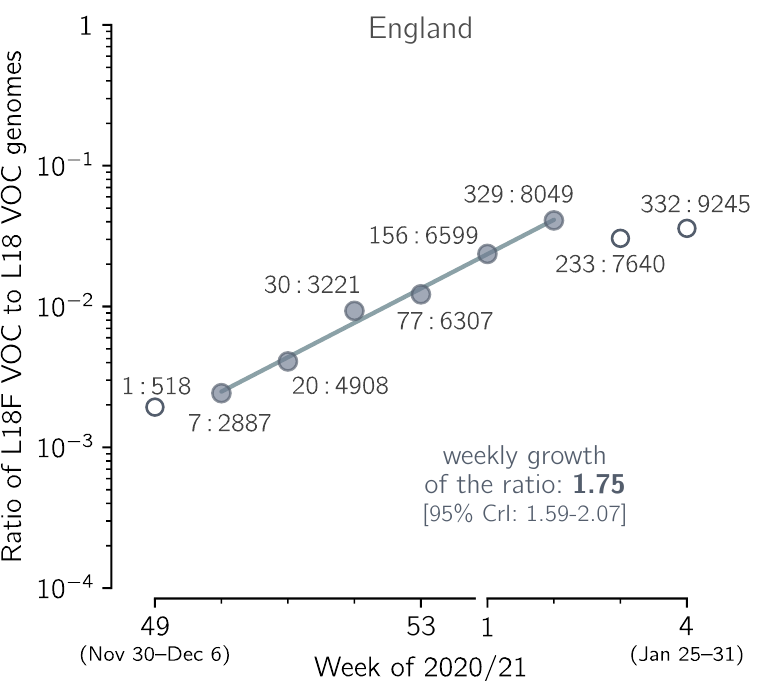
Figure 7. The growth of the spike L18F substrain in relation to the L18 VOC strains. The ratio v L of the number of VOC genomes conferring spike L18F mutation to the number of non-mutated (L18) VOC genomes collected in the period between week 49 of 2020 and week 3 of 2021 in England. Data aggregated into weeks indicated that v L changes from 7:2887 = 0.0024 in week 50 of 2020 to 329:8049 = 0.041 in the second week of 2021, i.e., 16.9 times, meaning that v L increases 16.9 1/5 = 1.76-fold per week. The trend line is fitted to data points shown as filled circles. The weekly growth rate of the ratio is 1.75. The 95% CI calculated as 1.96 × standard error of the slope is [1.66–1.85]; the 95% CrI calculated assuming binomial distribution of substrain genomes is [1.59–2.07]. Data points in week 50 of 2020 and week 2 of 2021 are labeled with ratios of the counts of both types of genome sequences. The figure is based on GISAID data submitted until 12 February 2021 (provided in Supplementary Data File